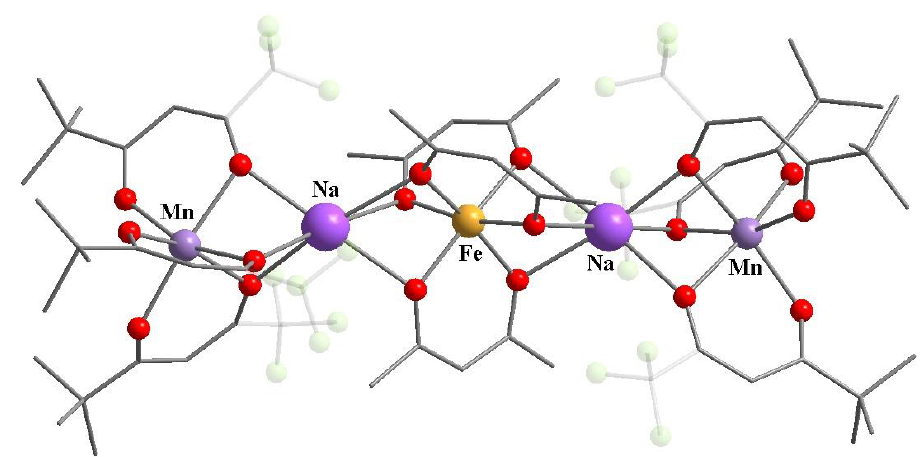
Figure 7. Molecular structure of 17 [68]. Hydrogen atoms have been omitted, CF 3 groups of hfac are transparent for clarity. The cif has been retrieved from CCDC. CCDC number is 1998879.